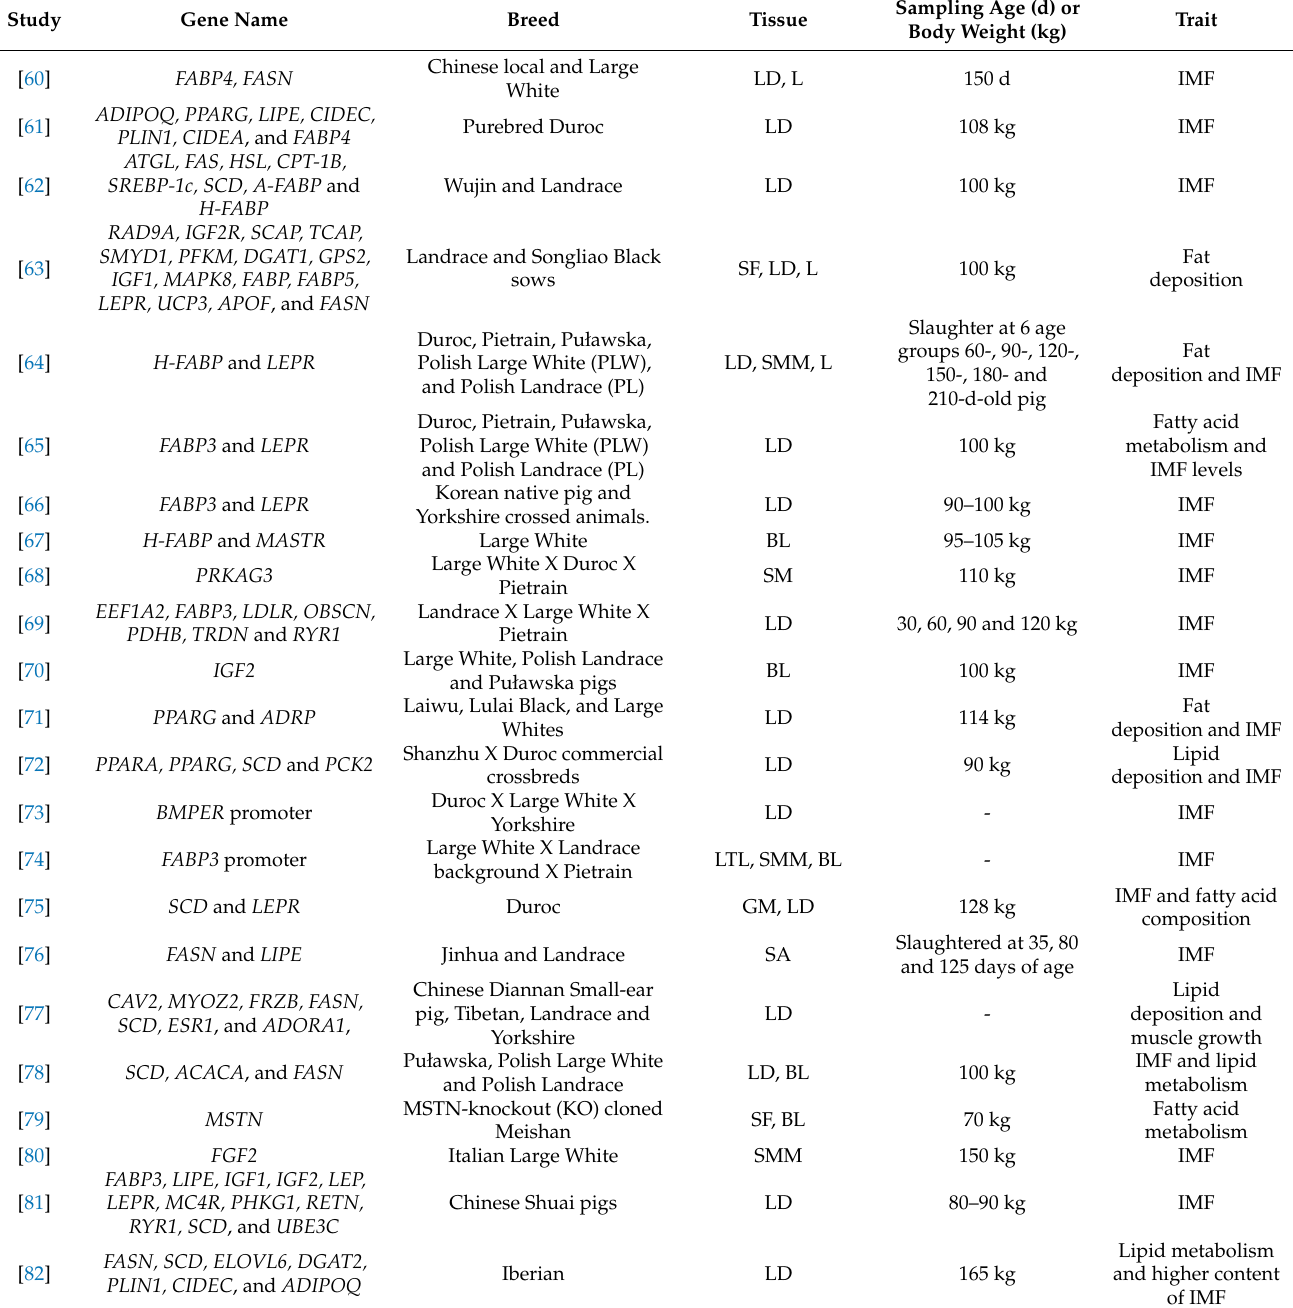
Table 1. A list of genes related to fat metabolism and IMF deposition in